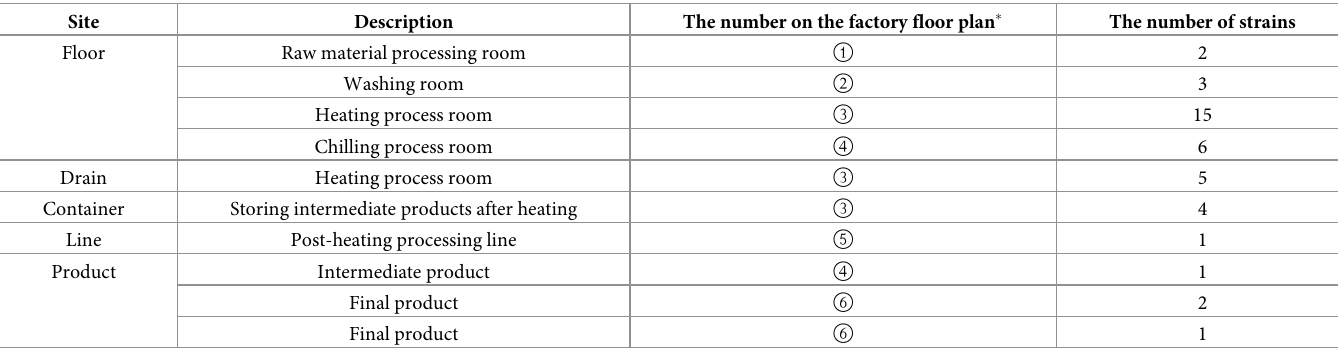
Table 1. Details regarding the 40 strains of E . coli used for cgMLST